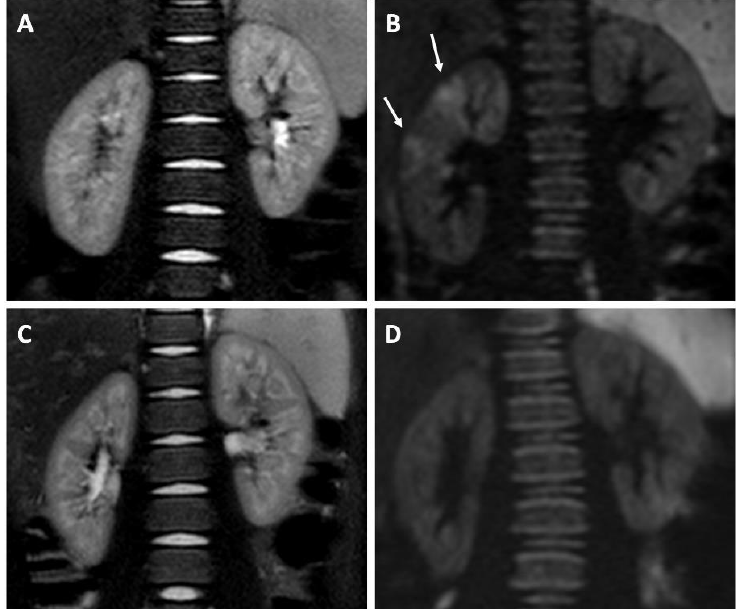
Figure 3. Patient with fUTI. ( A ) T2-MR sequence shows no signs of acute parenchymal involvement and renal scarring at the moment of the acute episode; ( B ) signs of acute parenchymal involvement detected by DWI ( b -value diffusion = 1000); ( C ) T2-MR sequence shows no sequelae 6 months after the end of treatment; ( D ) resolution of acute lesions 6 months after the end of treatment, as detected by DW-MRI ( b -value diffusion = 1000).